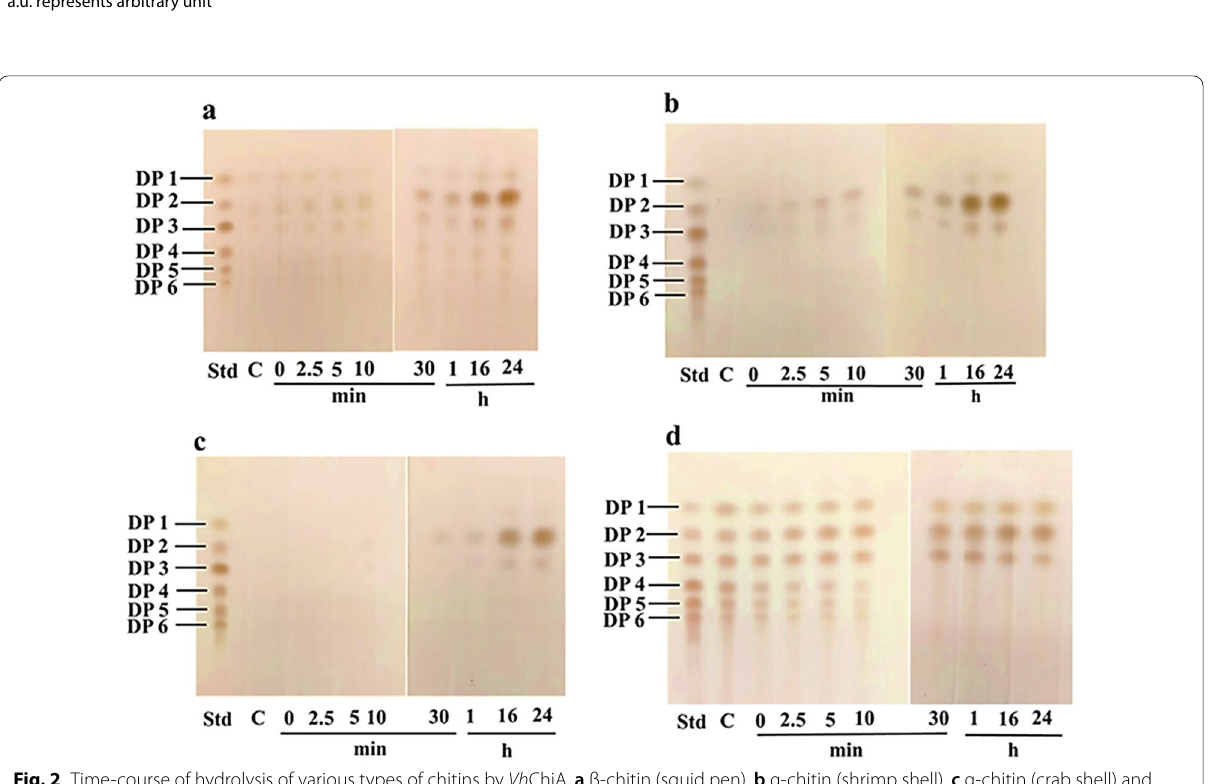
The intensities of migrating sugar spots were measured after 24 h of reaction for each polysaccharide, using ImageJ software (https:// imagej. nih. gov/ ij/) a a.u. represents arbitrary unit